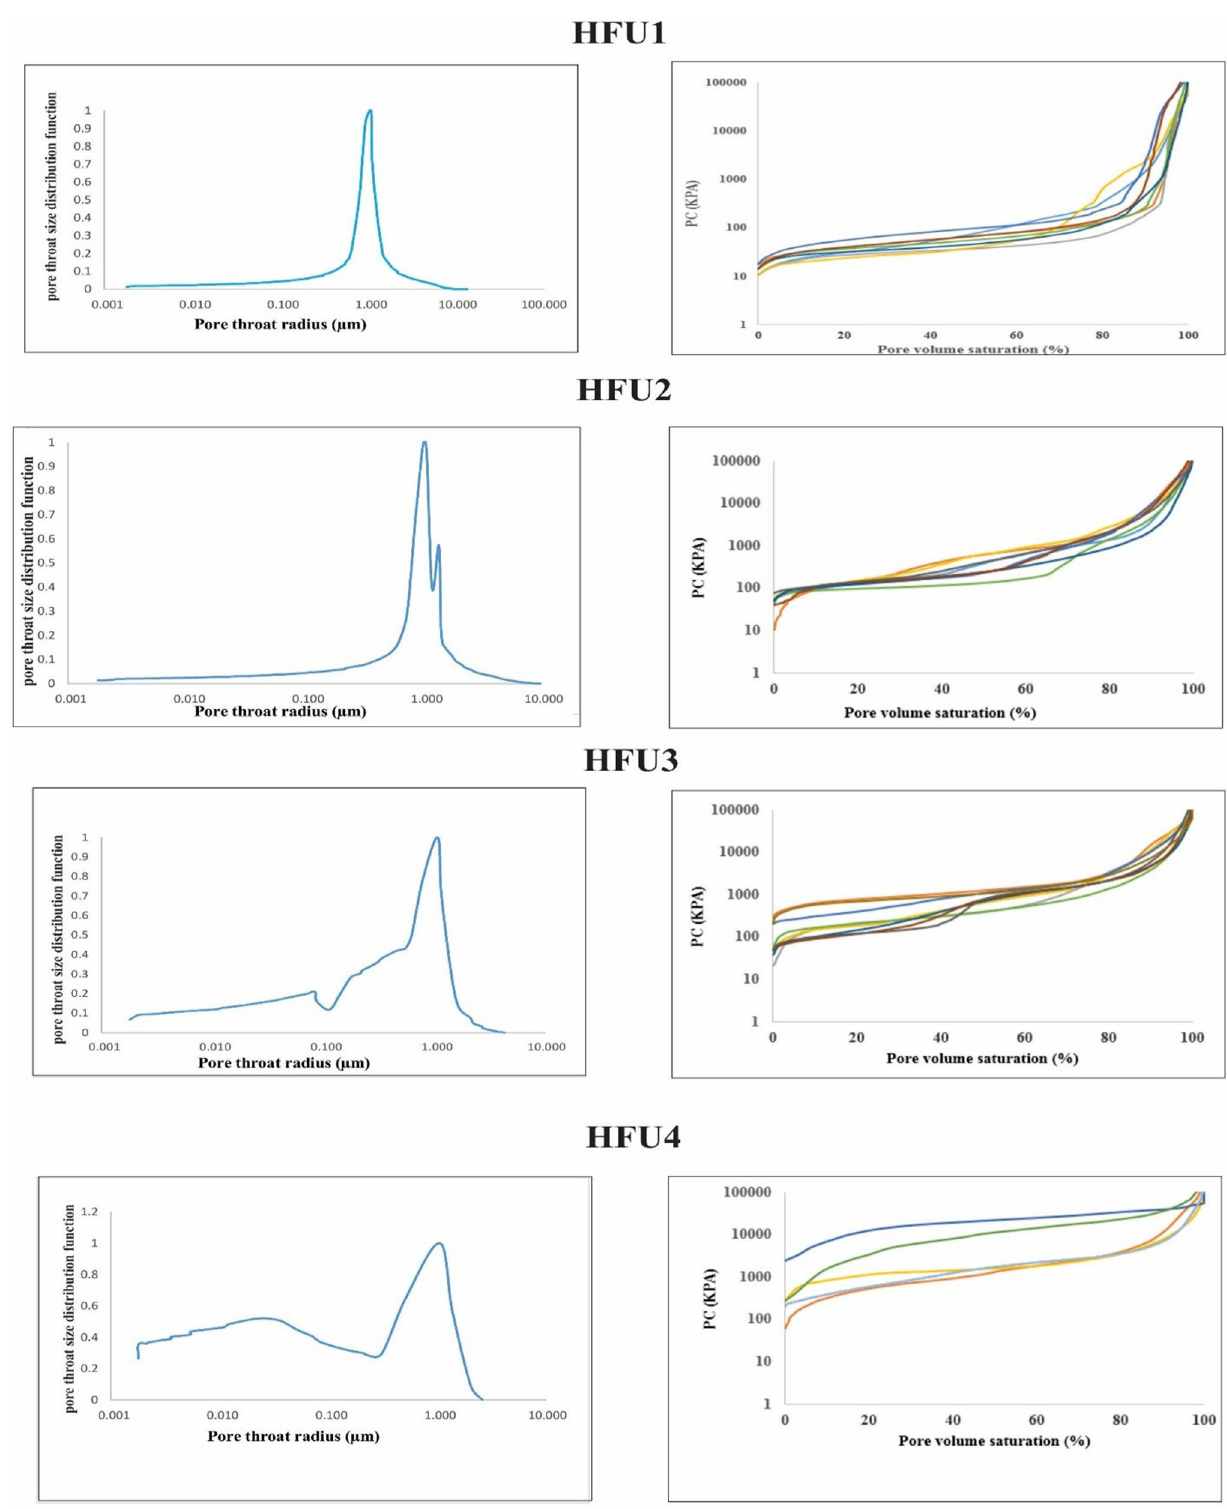
Fig. 11 PTSD plot for different